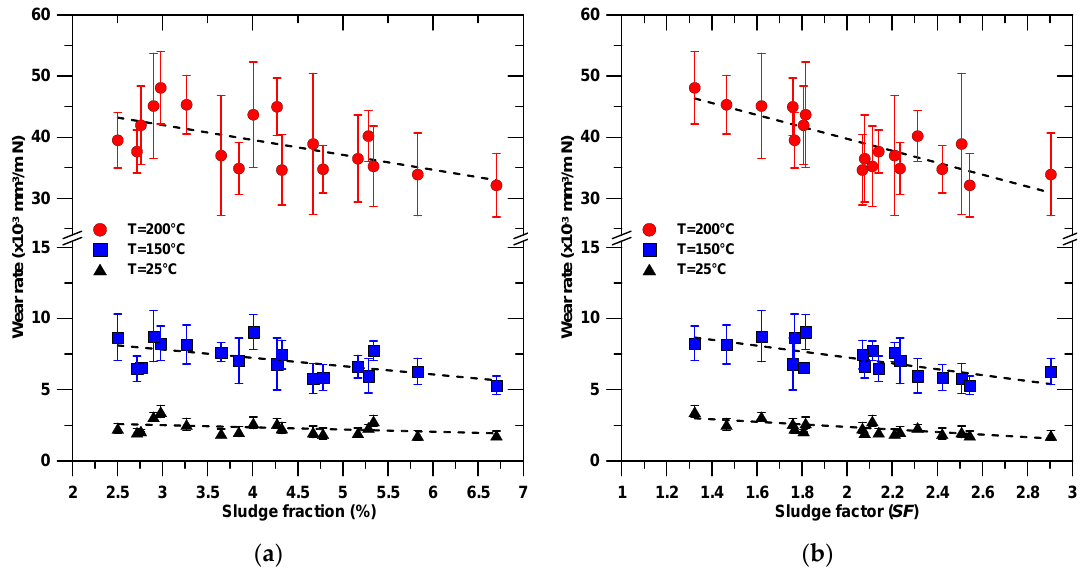
Figure 10. Average wear rate at di ff erent temperatures as function of ( a ) the sludge area fraction and ( b ) the sludge factor in the diecast experimental AlSi9Cu3(Fe) alloys. Table 5. Regression coe ffi cients used to estimate the wear rate at di ff erent temperatures through Equation (2), by using the SF expression. The R 2 and p -values are also reported. 316 SF Coefficient Room temperature 150 °C 200 °C a − 0.90